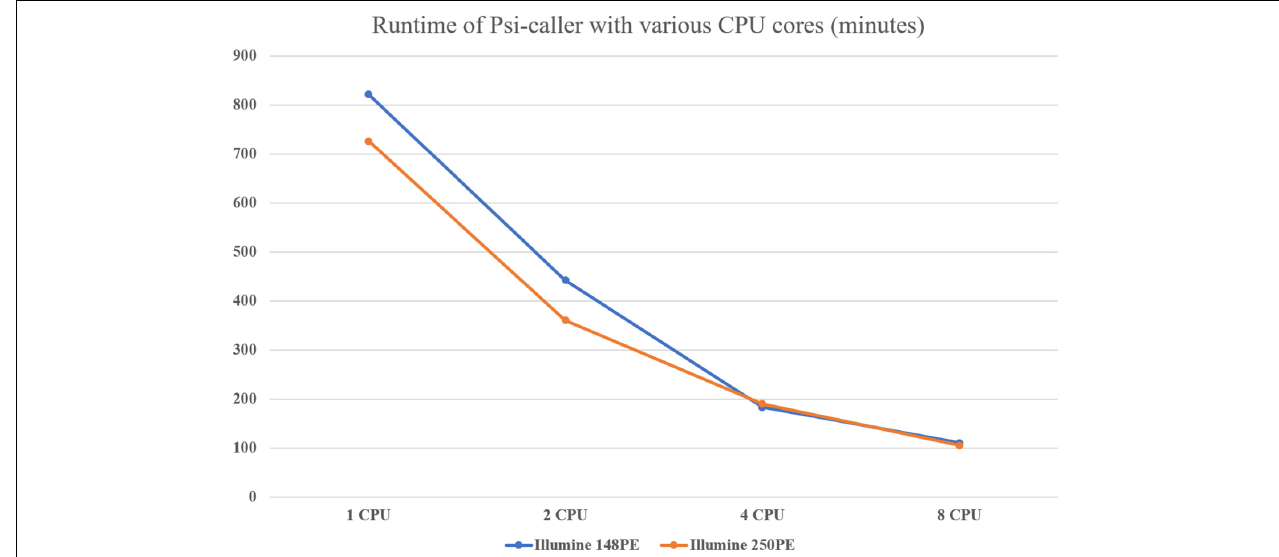
FIGURE 4 | Performance of Psi-caller using different number of